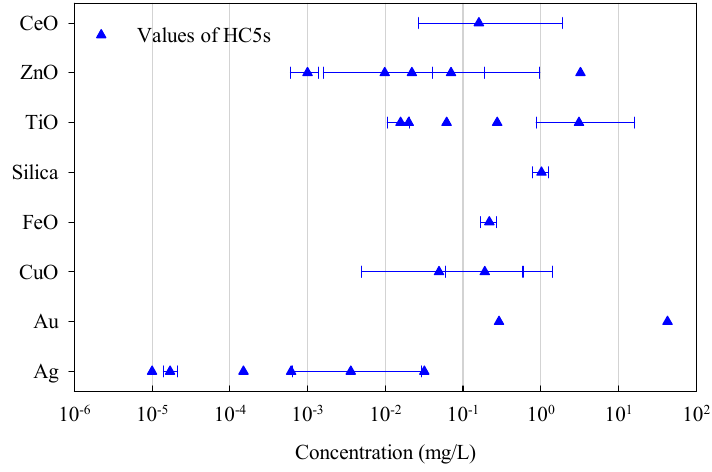
Figure 2. Estimated HC5s from SSDs (aquatic) for different types of ENMs. The relevant confidence intervals are also given (if available in the original publications).